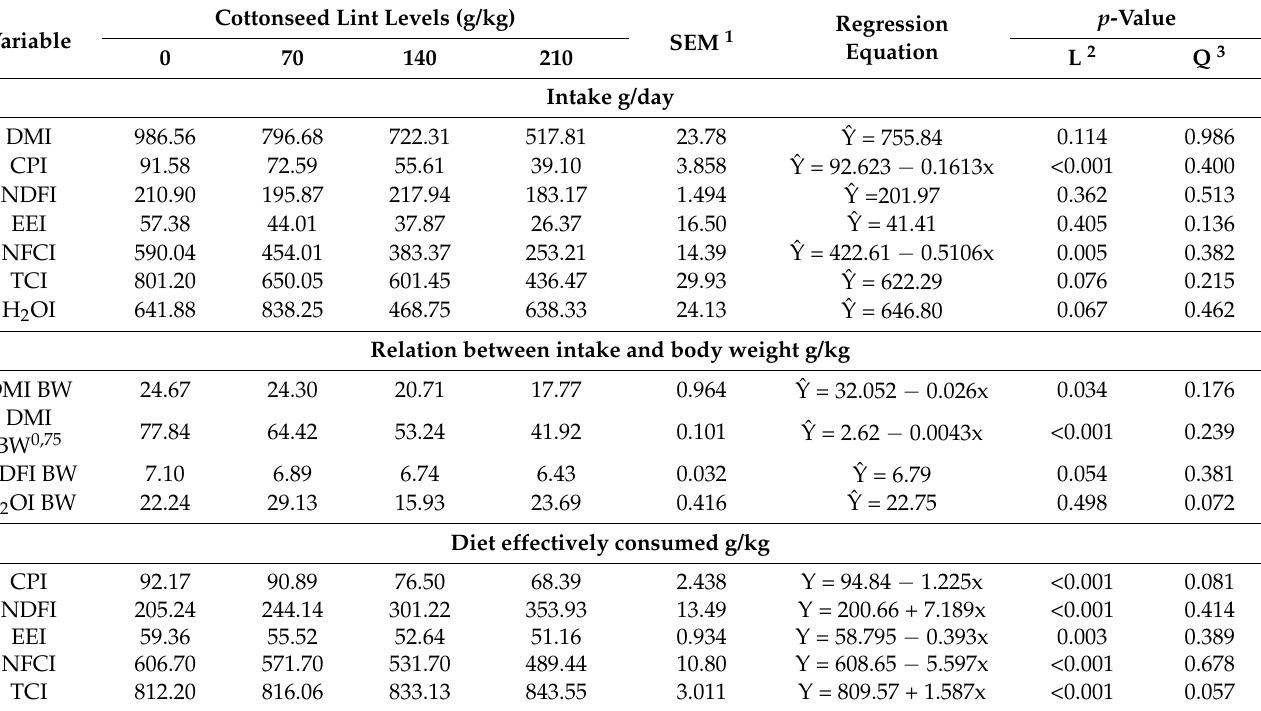
Table 4. Average intakes of dry matter (DMI), crude protein (CPI), ether extract (EEI), neutral detergent fiber (NDFI), non-fibrous carbohydrates (NFCI), total carbohydrates (TCI), total digestible nutrients (TDNI), indigestible neutral detergent fiber (iNDFI), and water (H 2 OI) of rams fed with cottonseed lint inclusion levels diets.